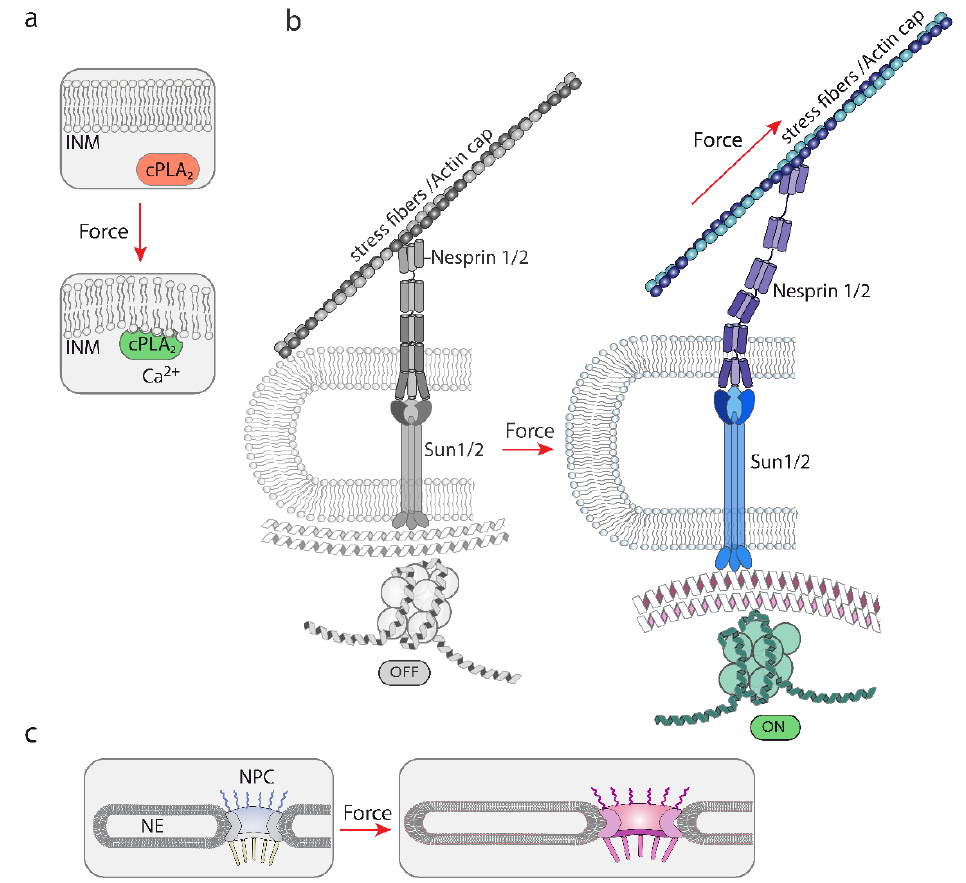
Figure 4. A graphical representation of the different proposed mechanisms of mechanosensing by nuclear structures. ( a ) The NE is mechanosensitive. Tension changes modify the structure of the NE, which modifies the binding sites for the mechanosensitive cPLA 2 . Calcium accumulation contributes to the activation of cPLA 2 [34]. Forces that alter lipid bilayers can be generated by osmolarity variations leading to changes in osmotic pressure. ( b ) A graphical representation of the model by which unfolding events in nesprin and SUN may lead to modifications in lamins and chromatin. This system is believed to rely on mechanical forces generated by actin polymerization and/or contraction of the actomyosin complex, which would pull from associated proteins, such as nesprins. These actions generate forces that would transmit mechanical cues up to the chromatin [2,40]. ( c ) A graphical representation illustrating the proposed sensitivity and adaptation of the NPC diameter to mechanical cues [41–43]. Hyperosmolarity [43] and ECM rigidity [42] have been shown to alter the NPC diameter.